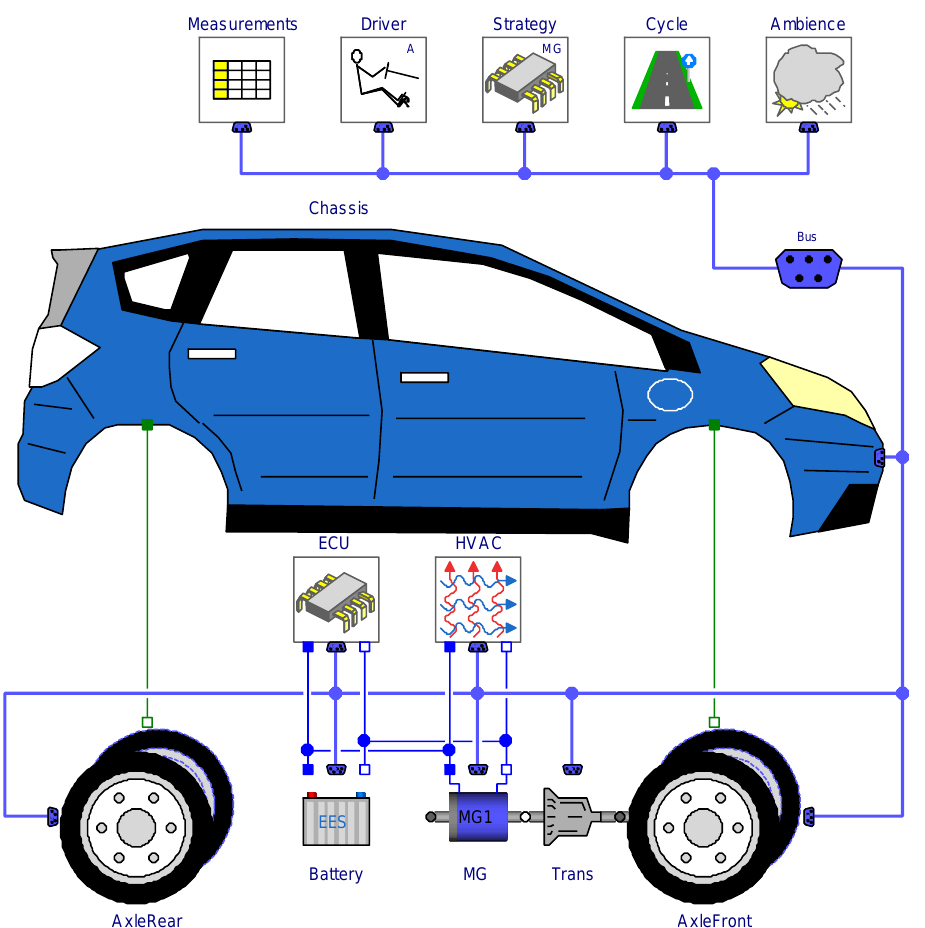
Figure 2. Reference vehicle model of the Honda Fit EV modelled in